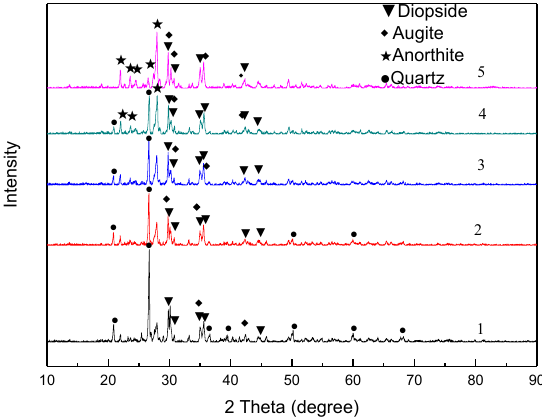
Figure 3. XRD spectra of samples 1–5 at optimum sintering temperature.